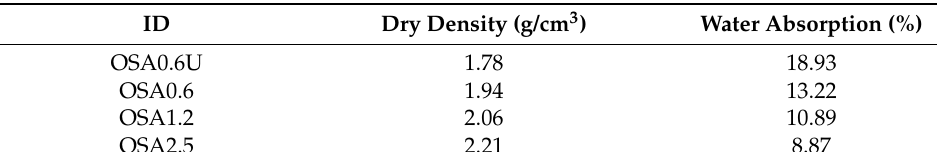
Table 3. Density and water absorption.